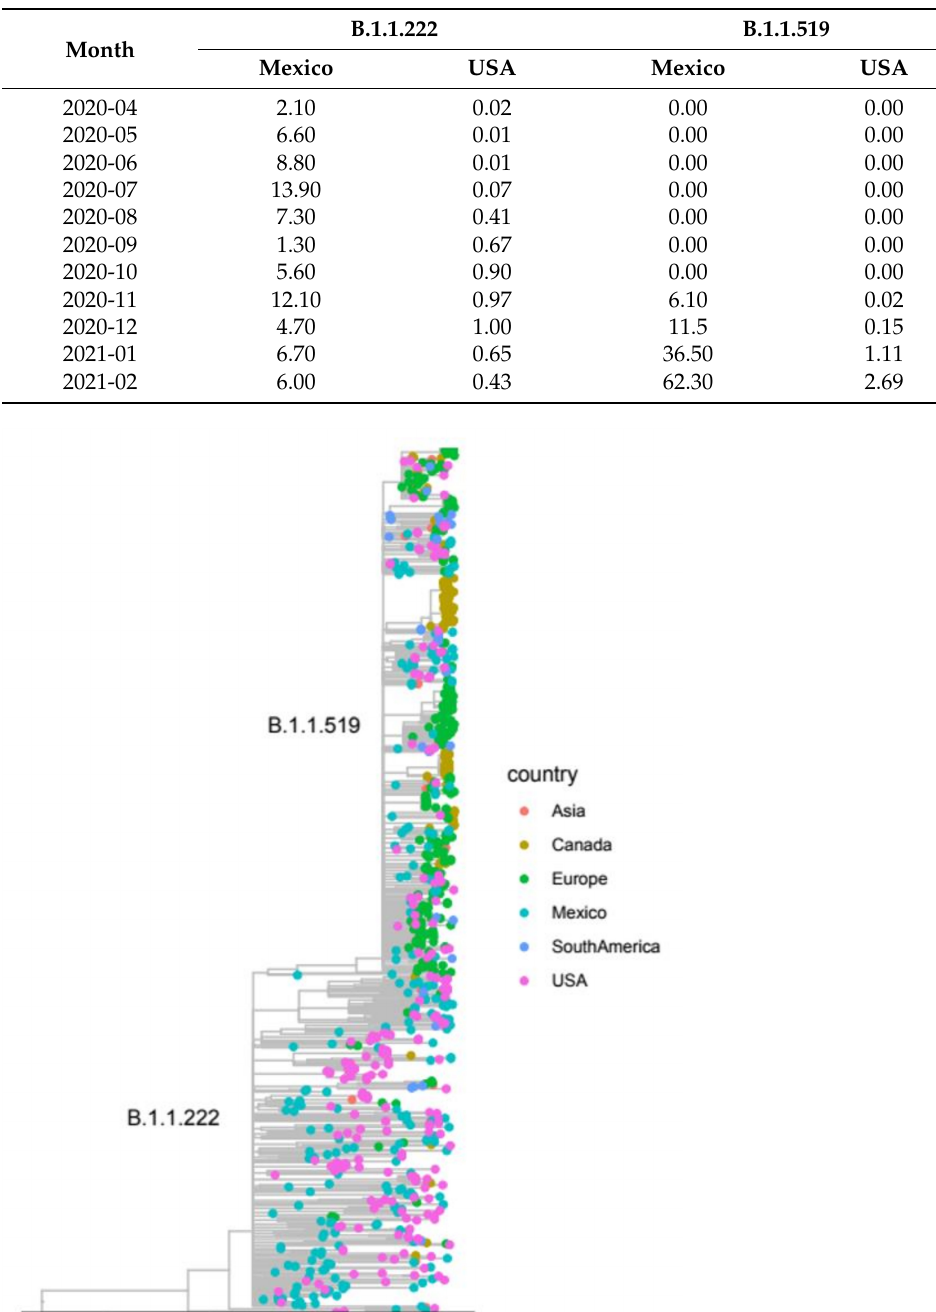
Table 3. Monthly percentage of sequences classified as B.1.1.222 and B.1.1.519.